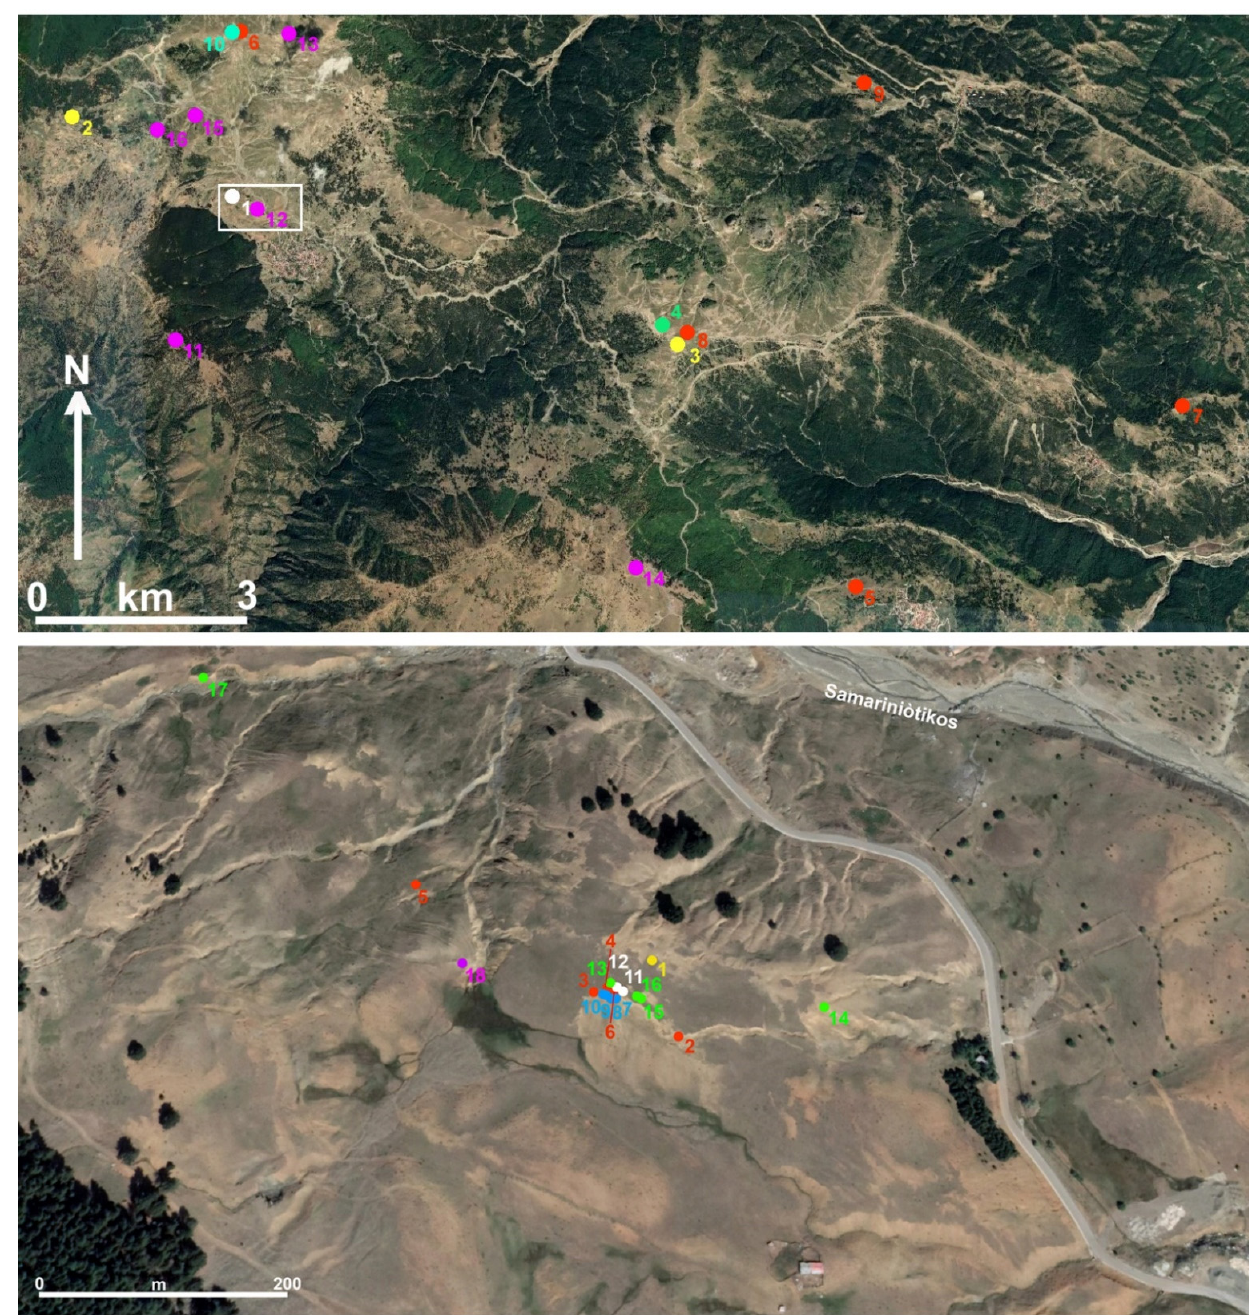
Figure 2. Distribution map of the radiocarbon-dated sites in the study area: HC-CH-20 (n. 1), BGD-1 (n. 2), NTS-25 (n. 3), Sam-23 (n. 4), SMX-1 (n. 5), Sam-8/2 and 8/4 (n. 6), KRN-45 (n. 7), Sam-29 (n. 8), AA-1 (n. 9), Sam-8/1 and 8/3 (n. 10), GRG-1 (n. 11), Samarina HC-5 and HC-4/CH1 (n. 12), Sam-5 (n. 13), VSL-1 (n. 14), SMR-1W (n. 15), and GVL-1 (n. 16). Mesolithic (white dot), Neolithic (blue dot), Chalcolithic (yellow dot), Bronze Age (red dot), Historical periods (violet dot). The white rectangle marks the location of the Historical Camp (HC) (top). Distribution map of the radiocarbon-dated tree-pits in the Historical Camp (HC): HC-102 (n. 1), HC-CH16 (n. 2), HC-115 (n. 3), HC-145 (n. 4), HC-CH9 (n. 5), HC-111 (n. 6), HC-144 (n. 7), HC-5/CH2 (n. 8), HC-146 (n. 9), CHR-4 (n. 10), CH-3 (n. 11), HC-105 (n. 12), HC-147 (n. 13), Grevena-1 (n. 14), HC-143 (n. 15), HC-107 (n. 16), HC-133 (n. 17), and CHR-5 (n. 18). Chalcolithic (yellow dot), Bronze Age (red dot), Iron Age (blue dot), Roman Age (white dot), Byzantine period (green dot), Medieval period (violet dot) (bottom) (drawings by P. Biagi and E. Starnini).